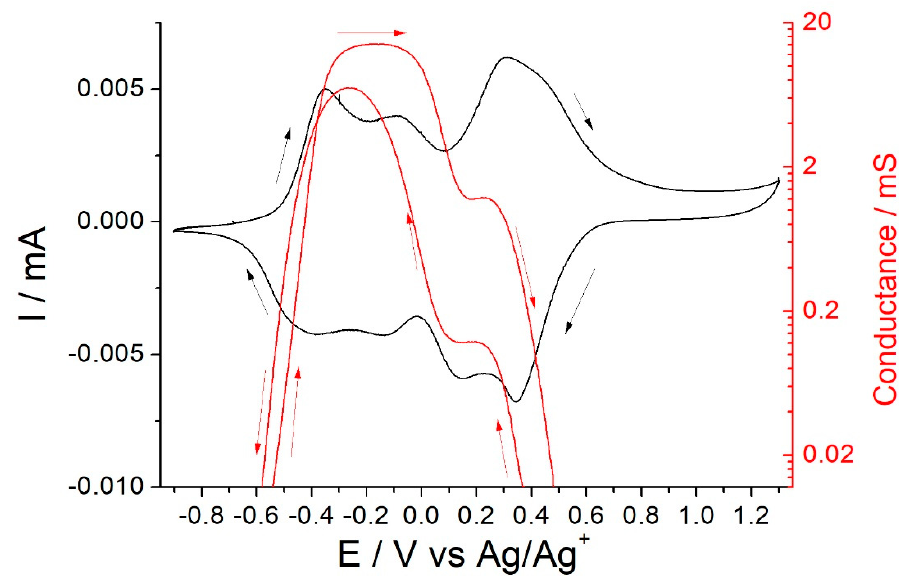
Figure 8. Cyclic voltammogram (black curve) and corresponding conductance profile (red curve) of a poly-[Co(Amben)]-coated interdigitated electrode in 0.1 M Et 4 NBF 4 /EC/DEC at a scan rate of 10 mV s − 1 with 5 mV bias.